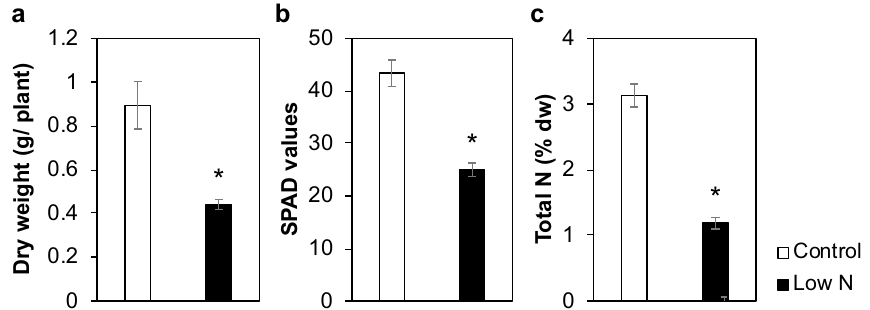
Figure 1. Effect of low-N treatment on hydroponically-grown sorghum seedlings growth. ( a ) Dry weight, ( b ) soil plant analysis development (SPAD) values, and ( c ) N content of hydroponically-grown sorghum seedlings cultivated under control or low-N conditions at 3 weeks after treatment. Values are means ± SD (n = 3). Asterisks indicate significant differences between control and low-N plants. (Student’s t test, p <